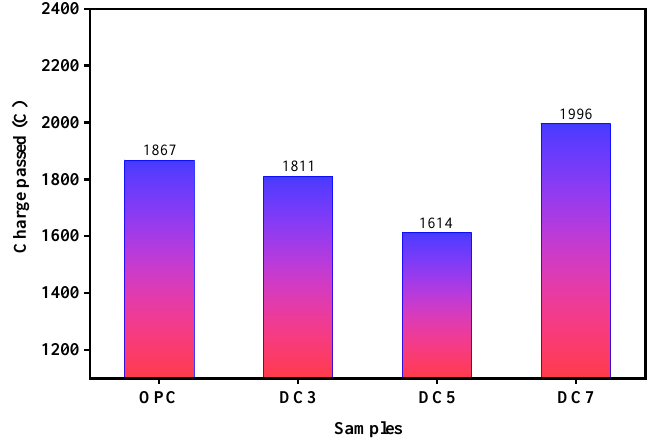
Figure 11. Charge passed of samples.